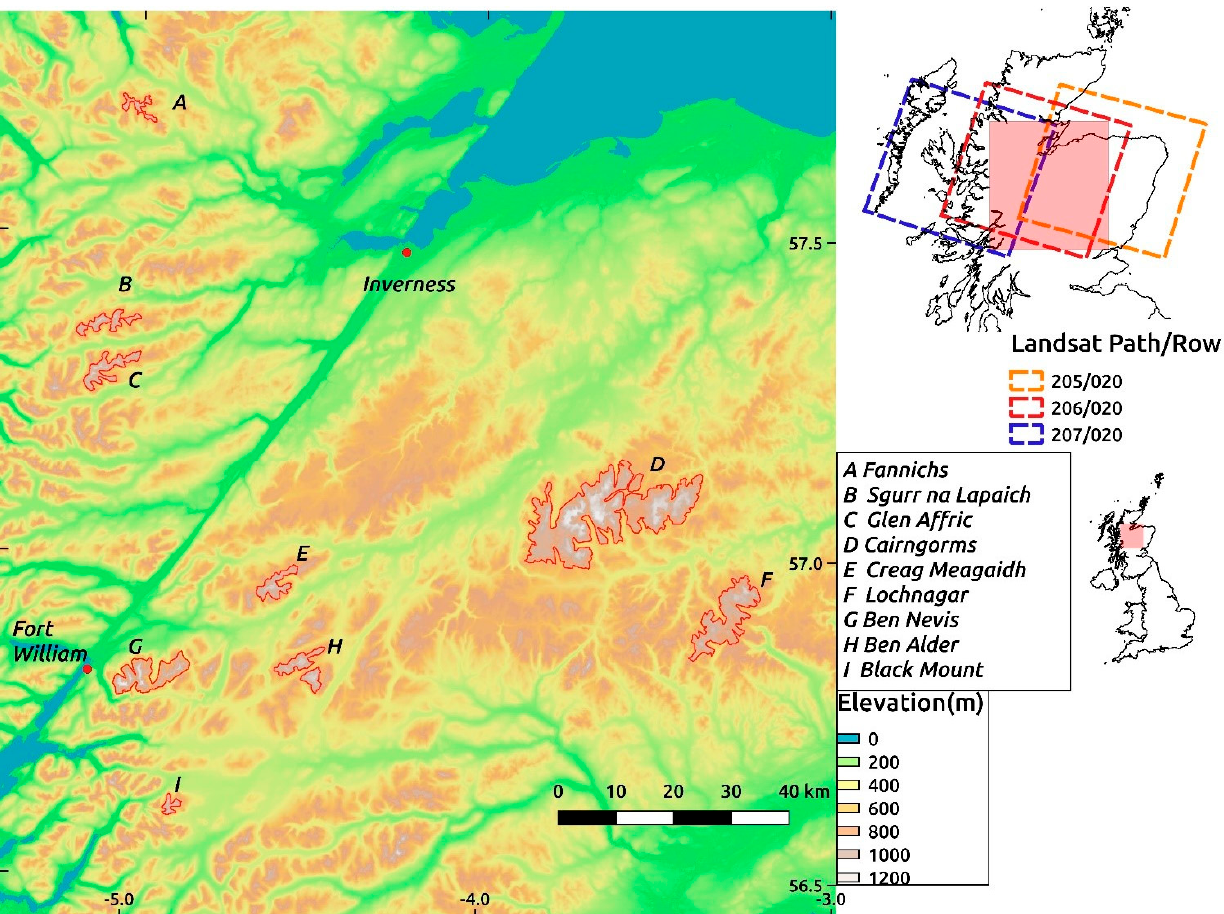
Figure 1. Map of location of study areas with background shading showing elevation